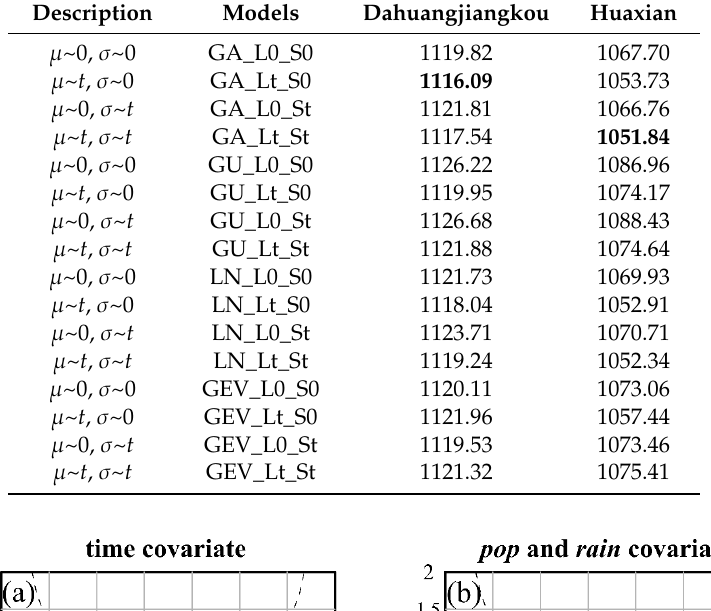
Table 2. Akaike Information Criterion (AIC) values of the nonstationary models with time covariate. Note that letter “L” in the models’ names represents location parameter µ and “S” represents scale parameters σ . Number “0” means the parameter is invariant while “t” means the parameter varies with time covariate. In addition, the AIC value in bold is the optimal model for each station.